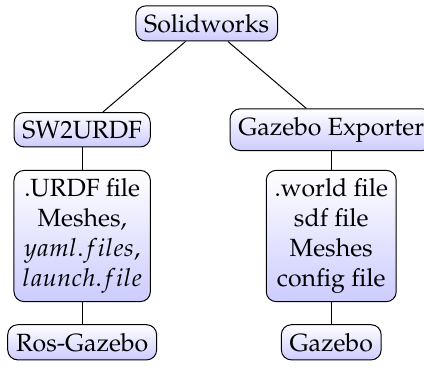
Figure 7. Flow chart for modelling a generic system from Solidworks to